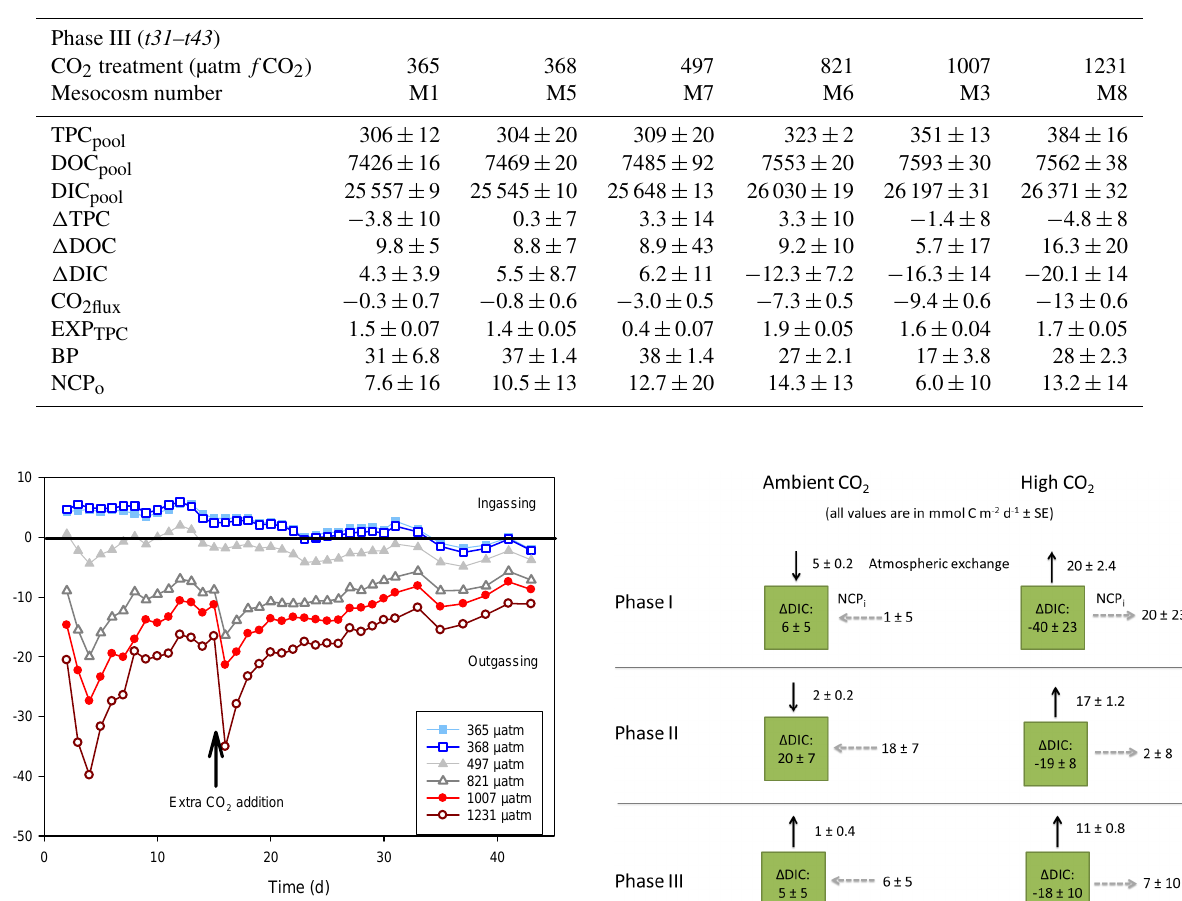
Table 3. The standing stock of total particulate carbon (TPC pool ), dissolved organic carbon (DOC pool ), and dissolved inorganic carbon (DIC pool ) at the start of phase III in mmolCm − 2 ± SE ( n = 2). The net change in TPC ( (cid:49) TPC), DOC ( (cid:49) DOC), and DIC ( (cid:49) DIC) are average changes in the standing stocks during phase III in mmolCm − 2 day − 1 ± SE ( n = 6), using the average of the last two sampling days as the end point. Flux measurements of atmospheric gas exchange (CO 2flux ) and exported carbon (EXP TPC ) plus biological rates – BP and net community production estimated based on organic carbon pools (NCP o ) – are all averages for phase III in mmolCm − 2 day − 1 ± SE ( n = 7, 6, and 7 for CO 2flux , EXP TCP , and BP, respectively). See Table 1 legend for further details. During phase III we did not have direct measurements of net primary production (NPP 14 ) or TR. C